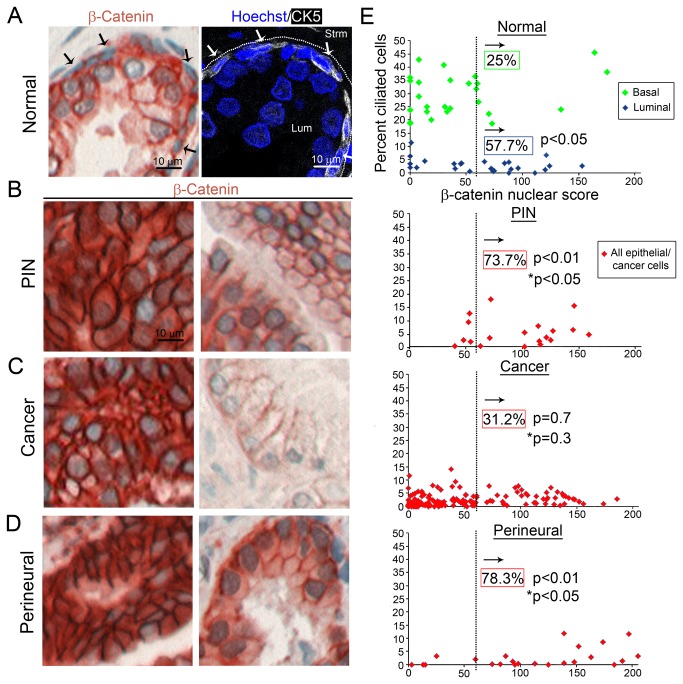
Primary cilia loss correlates with greater nuclear β-catenin in normal.(A) Immunohistochemistry (IHC) images of β-catenin staining in normal prostate, demonstrate a lack of β-catenin localization in basal cells (blue nuclei, black arrows; left). Basal cells were identified based on position, morphology, and cytokeratin 5 (CK5) staining in the adjoining serial section (white arrows; right). The lumen (Lum) and stroma (Strm) are labeled. IHC images show different levels and spatial distributions of β-catenin staining in (B) PIN, (C) cancer, and (D) perineural invasion. (E) Graphs display percent ciliated cells versus β-catenin nuclear score. Scattergraphs were plotted per location for normal, PIN, cancer, and perineural invasion tissue. For normal, basal cells (green) and luminal cells (blue) are shown. For PIN, cancer and perineural invasion, all epithelial/cancer cells are plotted red. High nuclear β-catenin was defined as the 75th percentile of normal, denoted by the dotted line, and was used to compare normal to PIN, cancer and perineural cells. Percentages represent the locations with high nuclear β-catenin. Statistical analysis was performed using linear regression and included all of the data points, and comparisons to normal basal cells are denoted with p, and comparisons to normal luminal cells are denoted with p*.